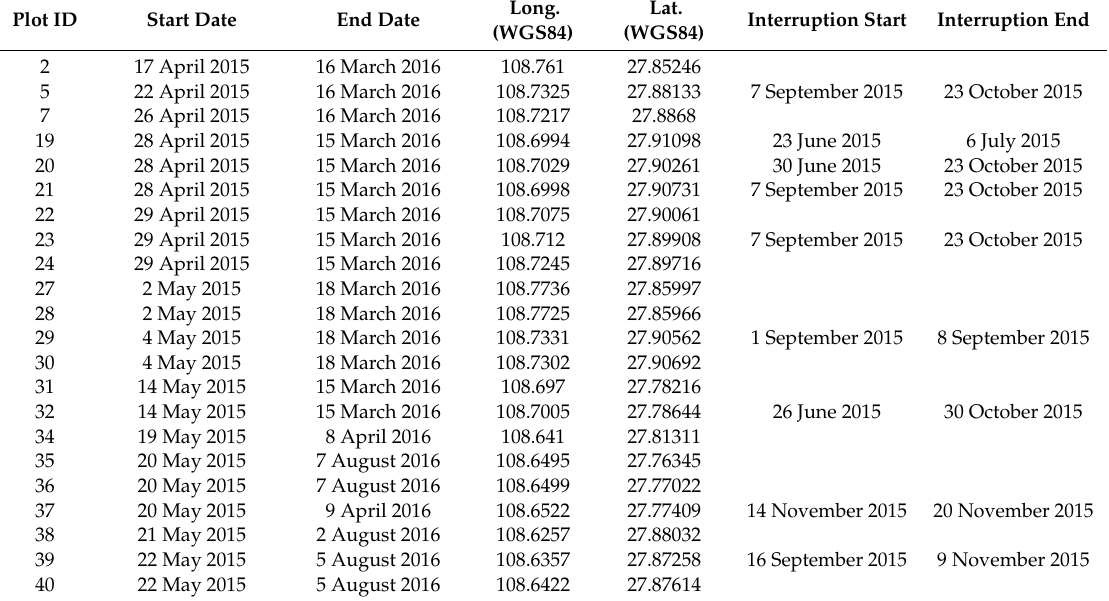
Table A2. Camera trap coordinates and dates of